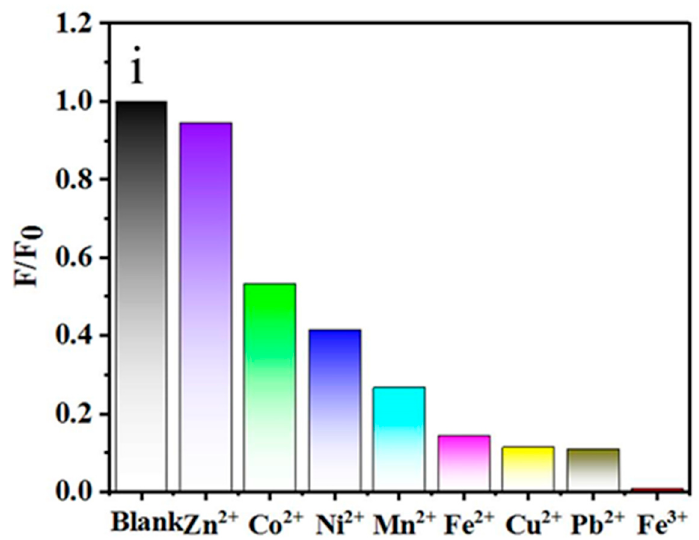
Figure 9. PL emission spectra of uCNT-15 in the presence of Zn 2+ ( a ), Co 2+ ( b ), Ni 2+ ( c ), Mn 2+ ( d ), Fe 2+ ( e ), Cu 2+ ( f ), Pb 2+ ( g ), and Fe 3+ ( h ) at different concentrations (mM/L). ( i ): Relative fluorescence intensity of uCNT-15 in the presence of different metal ions (F/F 0 , where F and F 0 represent the emission intensity of uCNT-15 in the presence and absence of the test substance, respectively). The concentration of all tested species was 1.5 mM/L.